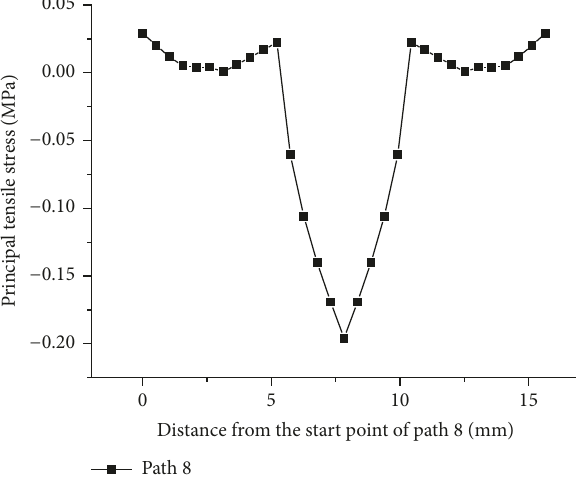
Figure 40: Principal tensile stress in the concrete specimen pre- stressed under a load of 10MPa when the displacement resulting from corrosion-induced expansion reaches 0.031 mm.